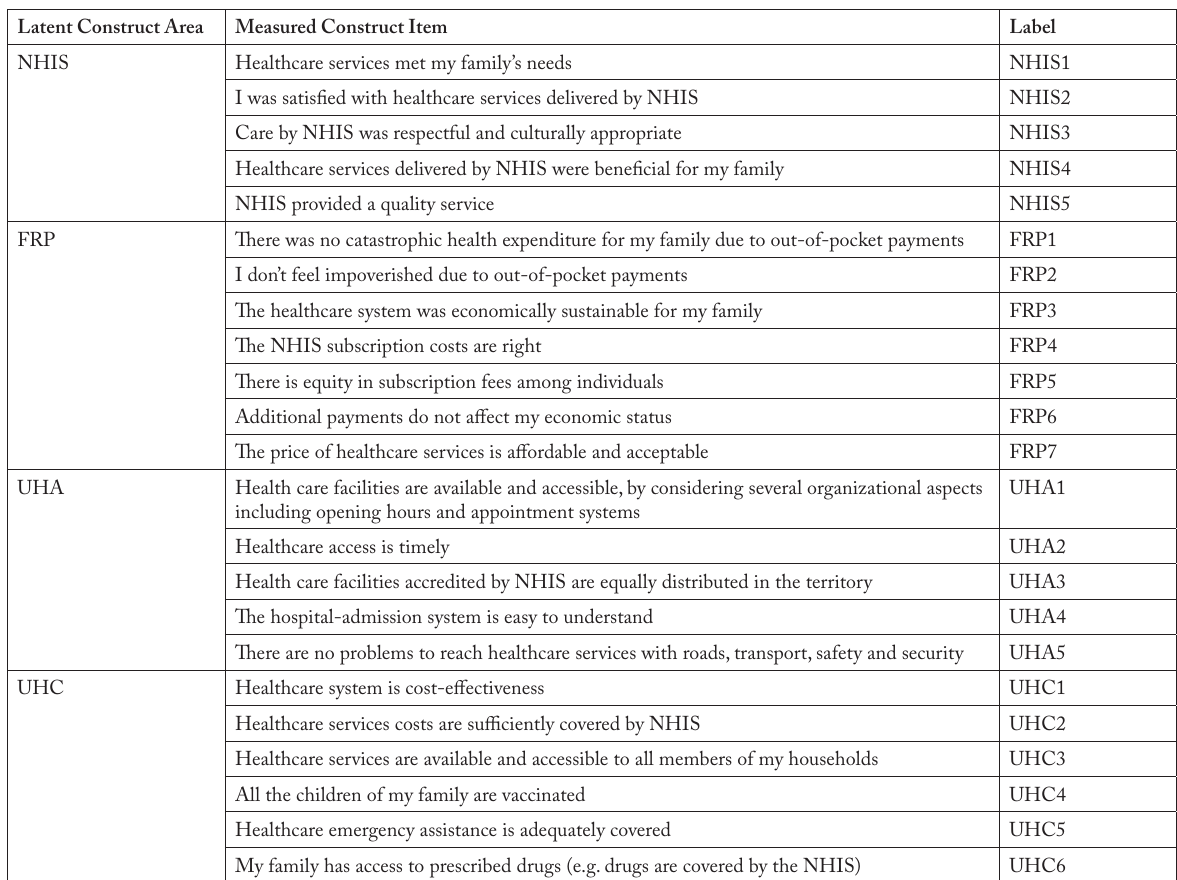
Table 1. Items of the questionnaire